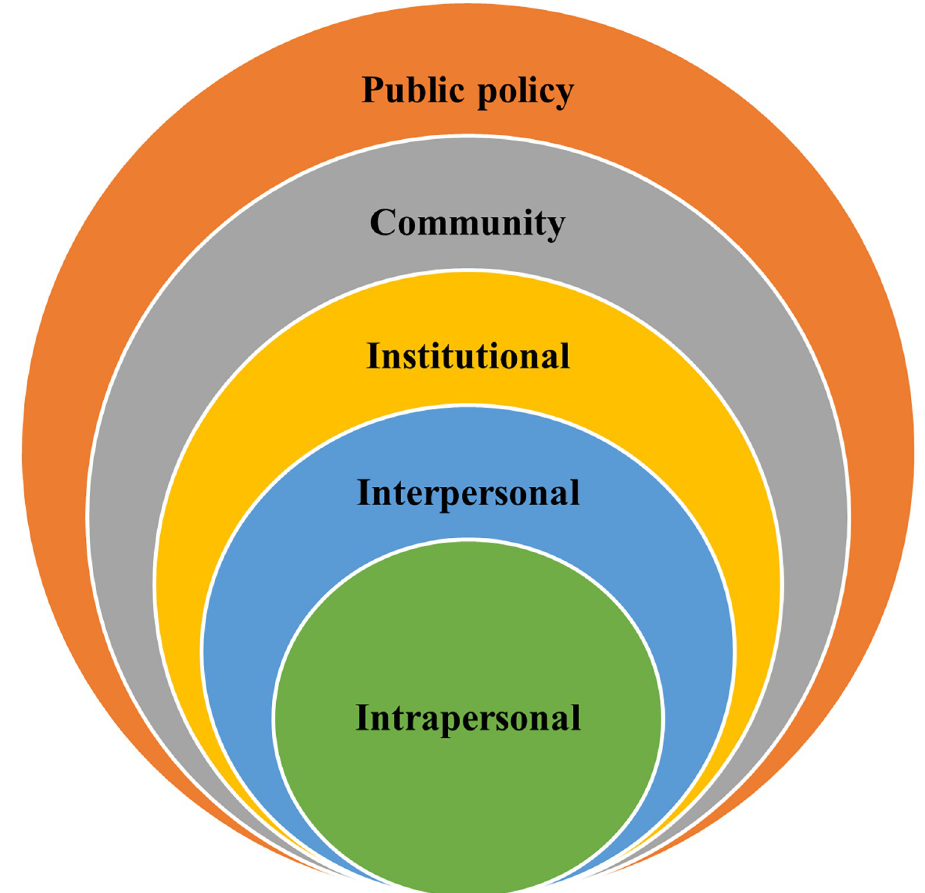
Fig 1. The levels of the socio-ecological model applied to this